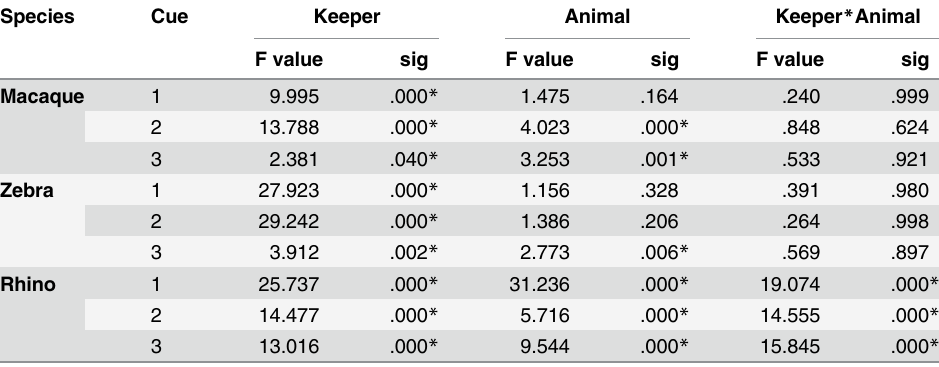
Table 2. Results from a two-way ANOVA showing main effects and interaction of the two main effects to show the variation in the performance of the appropriate behaviours of the macaques, zebra and rhino according to the different cues. Species Cue Keeper Animal Keeper * Animal F value sig F value sig F value sig Macaque 1 9.995 .000 * .164